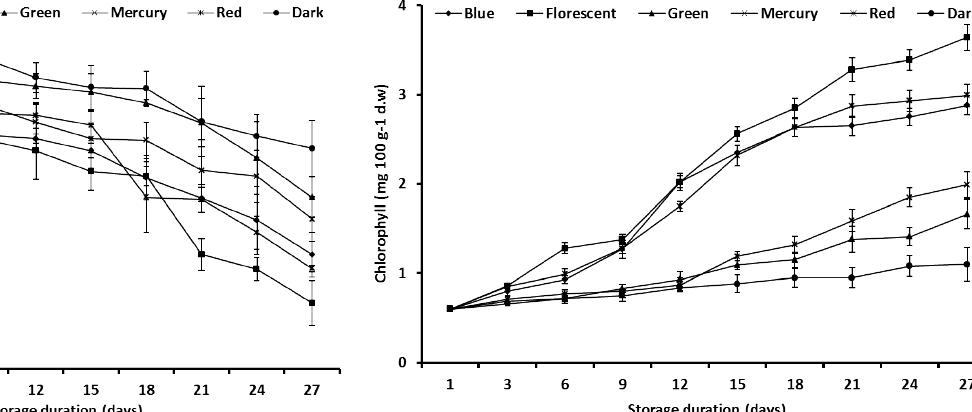
Fig. 4: Effect of different light source on ascorbic acid. Vertical bars show ±SE of means (n=3). Interaction between storage duration and light sources was significantly different at p ≤ 0.05.